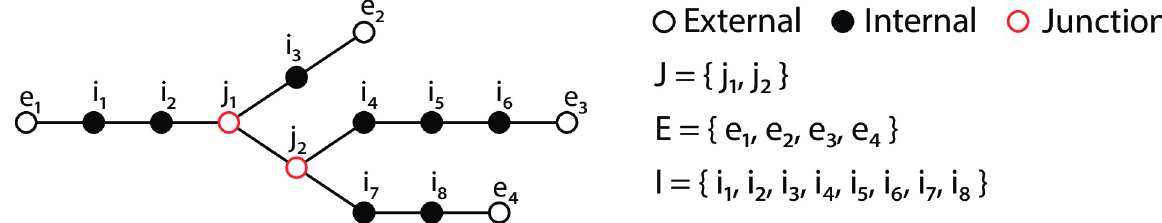
Fig 1. An illustrative example of a single graph (of many) identified following edge connection. Circular keys, top right, indicate node type, while black lines represent edges. The contents of each set, E, J and I, are shown.